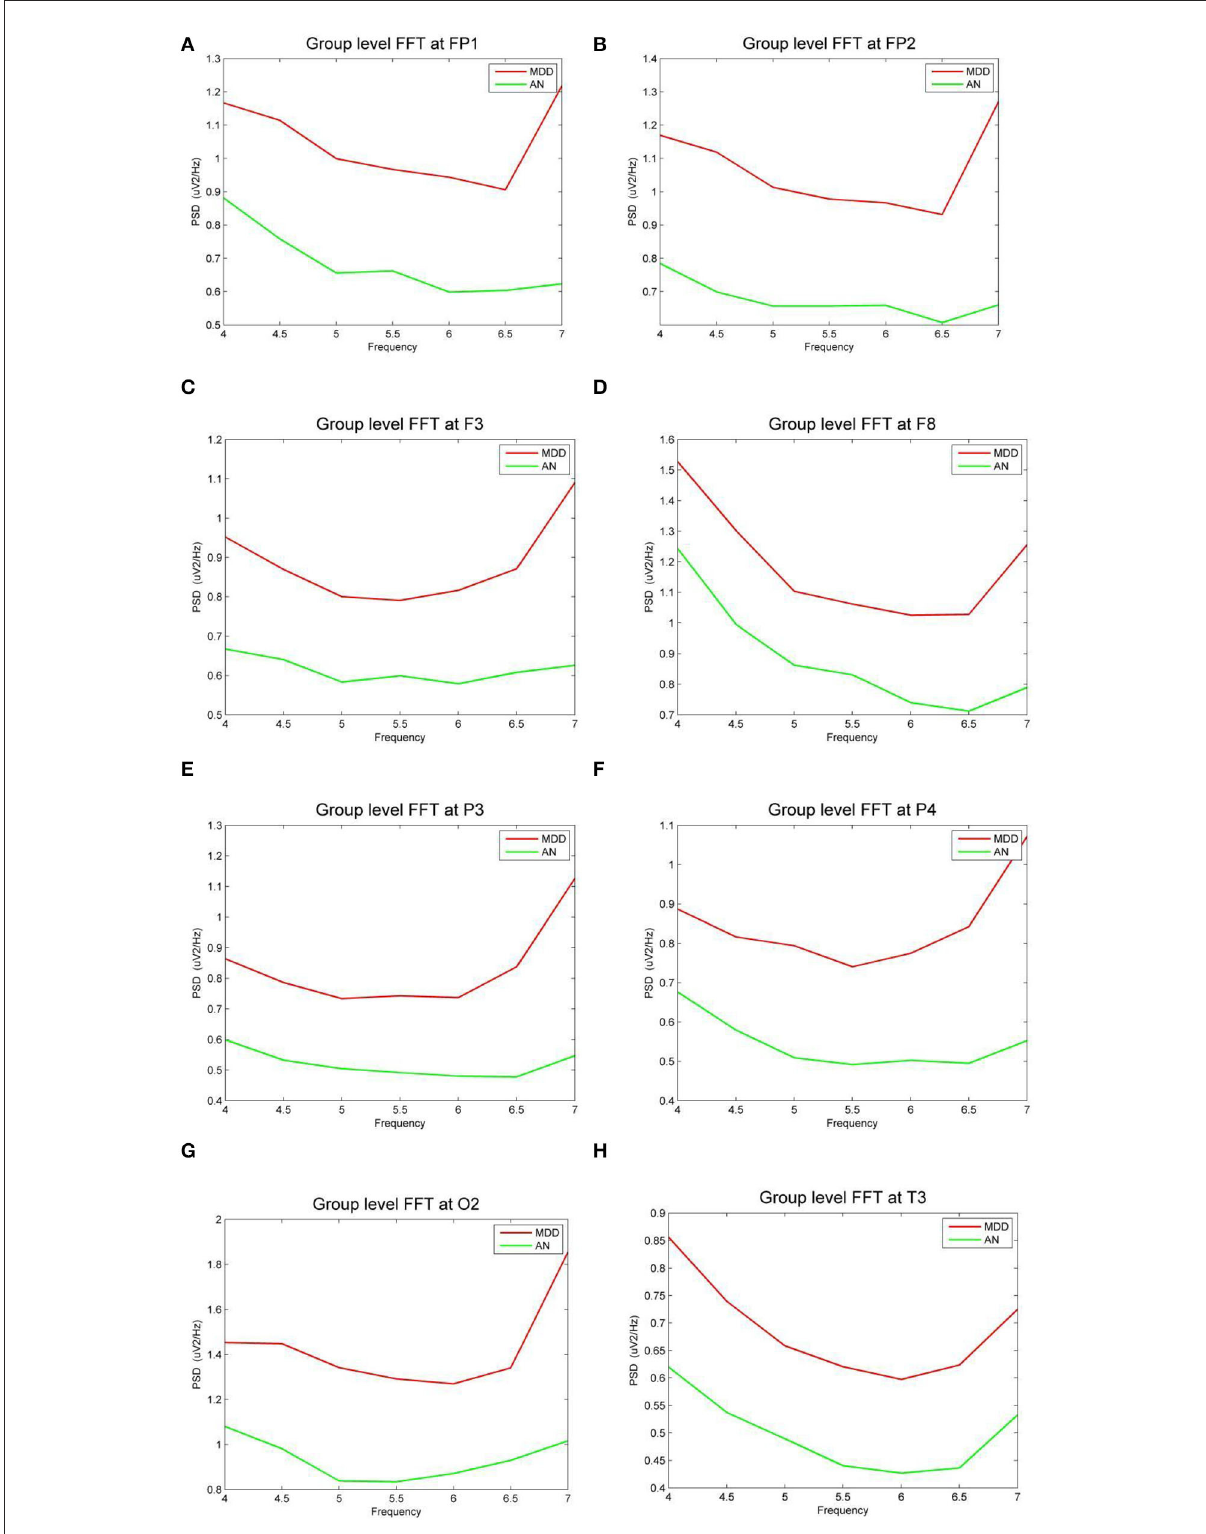
FIGURE3 (A–H) The power spectral density (PSD) for the different electrode sites according depressive group (MDD) and anxiety group (AN). The horizontal axis represents the EEG frequency, the vertical axis represents the EEG PSD, the red line represents MDD group, and the green line represents AN